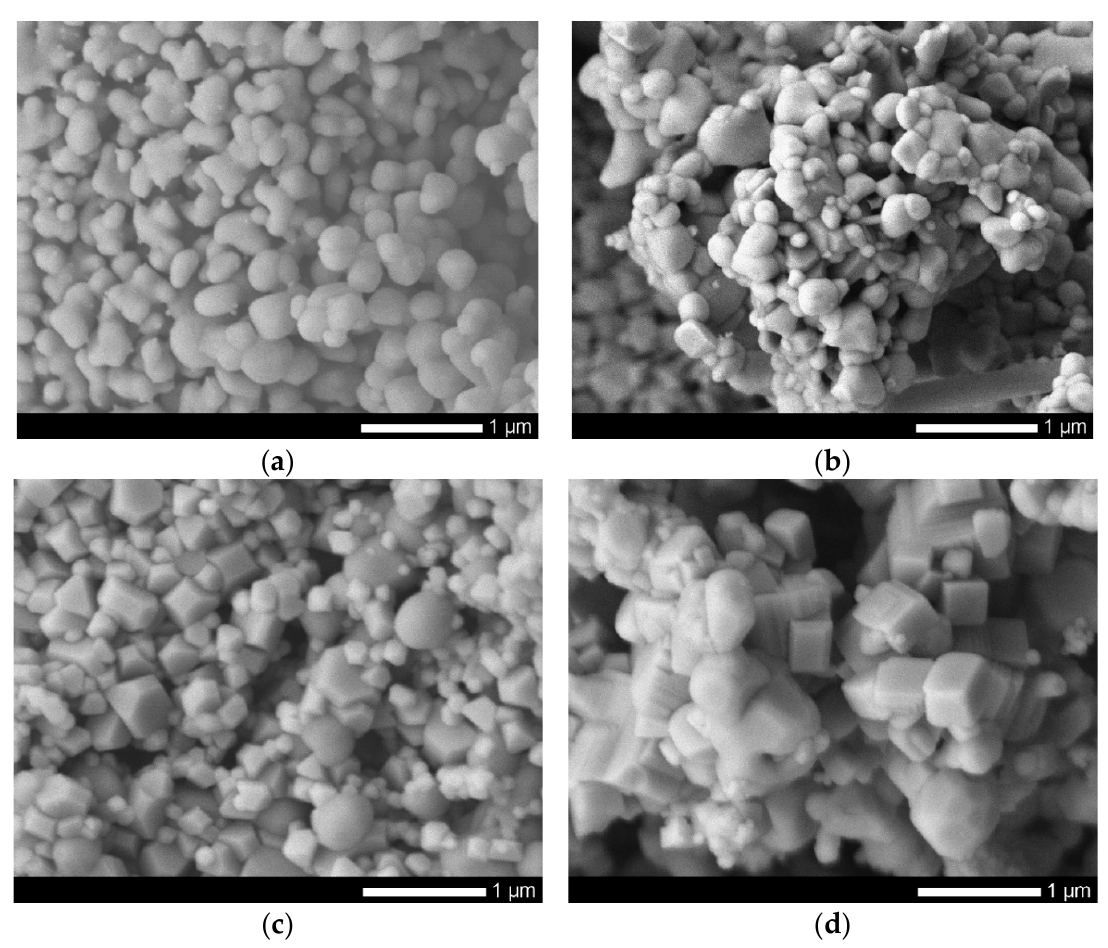
Figure 1. SEM images of synthesized nanoparticles: ( a ) FeCeO x nanoparticles; ( b ) 0.9FeCeO x + + 0.1Nb + 0.2 Nb 0.1Nb 2 O 5 nanoparticles; ( c ) 0.8FeCeO x + 0.2 Nb 2 O 5 nanoparticles; and d ) 0.7FeCeO x + 0.3 Nb 2 O 5 2 O 5 nanoparticles; ( c ) 0.8FeCeO x 2 O 5 nanoparticles; and ( d ) 0.7FeCeO x nanoparticles. Nb 2 O 5